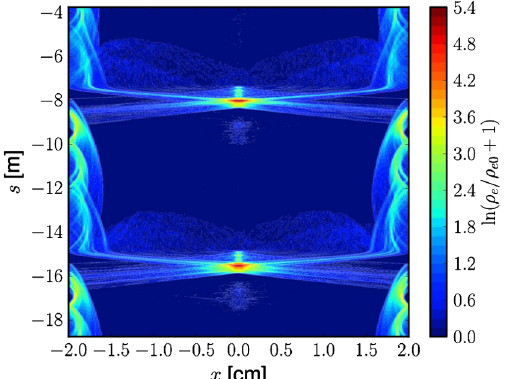
FIG. 8. Contour plot of the saturated electron cloud density obtained from the 2D simulation for LHC parameters. The electron cloud charge density (cid:2) e is used to normalize the color